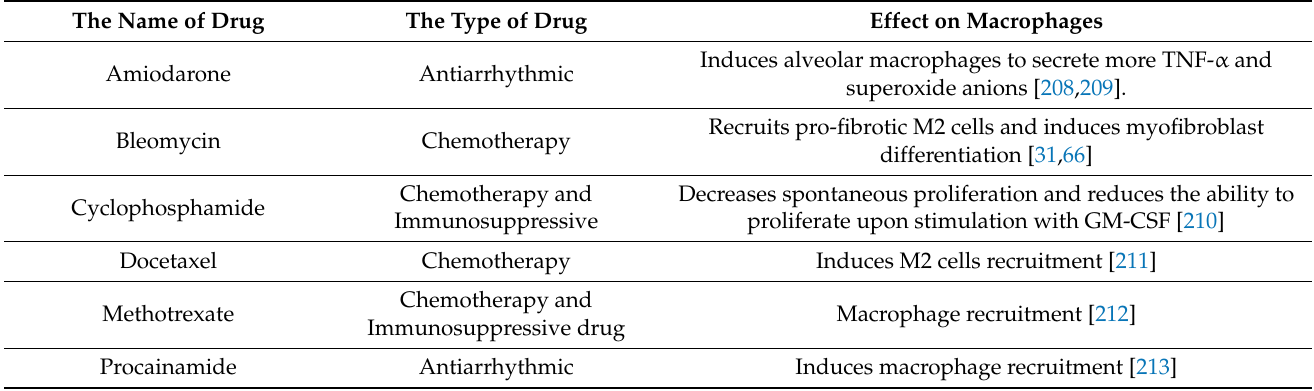
Table 2. Therapeutics that could exacerbate the fibrotic process via macrophage